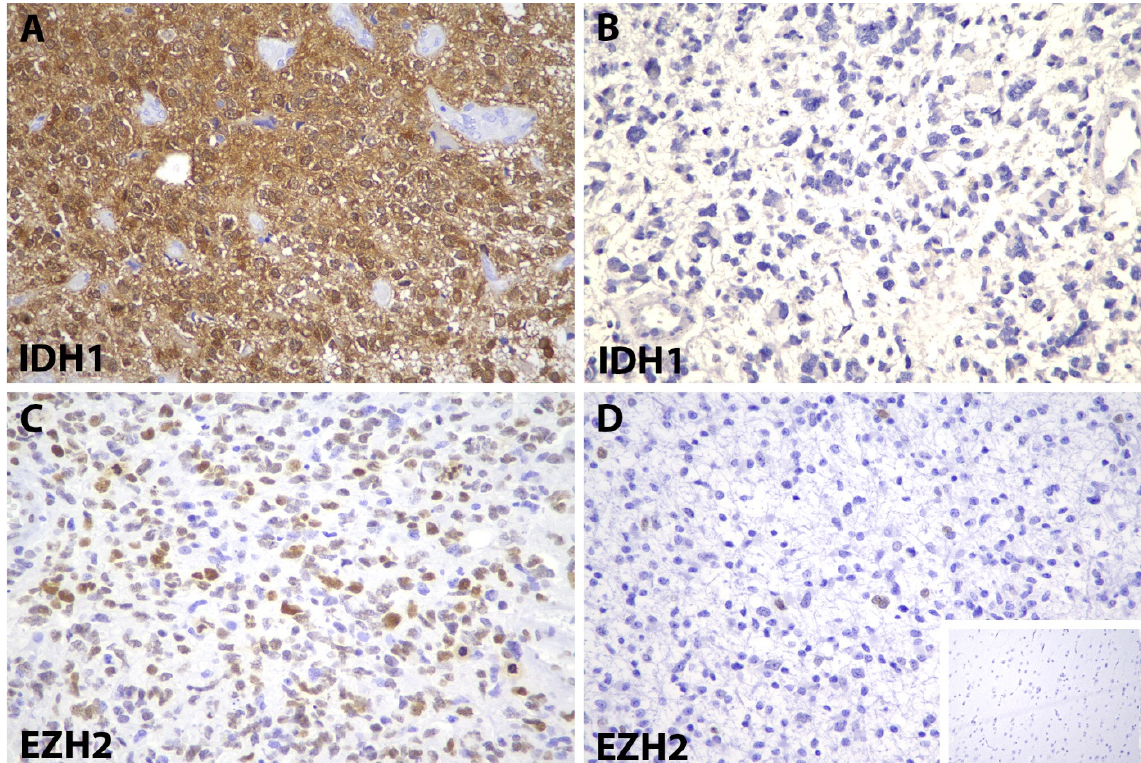
Figure 1. Immunostaining for IDH1 R132H protein mutant and EZH2 in gliomas. ( A ) IDH1 R132H- positive in a case of astrocytoma, grade 4 (IDH1, × 400). ( B ) IDH1 R132H-negative in a case of astrocytoma, grade 3 (IDH1, × 400). ( C ) High EZH2 expression in a case of glioblastoma, grade 4 (EZH2, × 400). ( D ) Low expression of EZH2 in a case of astrocytoma, grade 2. Inset shows EZH2 immunonegativity in adjacent reactive brain tissue (EZH2, × 400). Abbreviations: IDH, isocitrate dehydrogenase; EZH2, enhancer of zeste homologue 2.